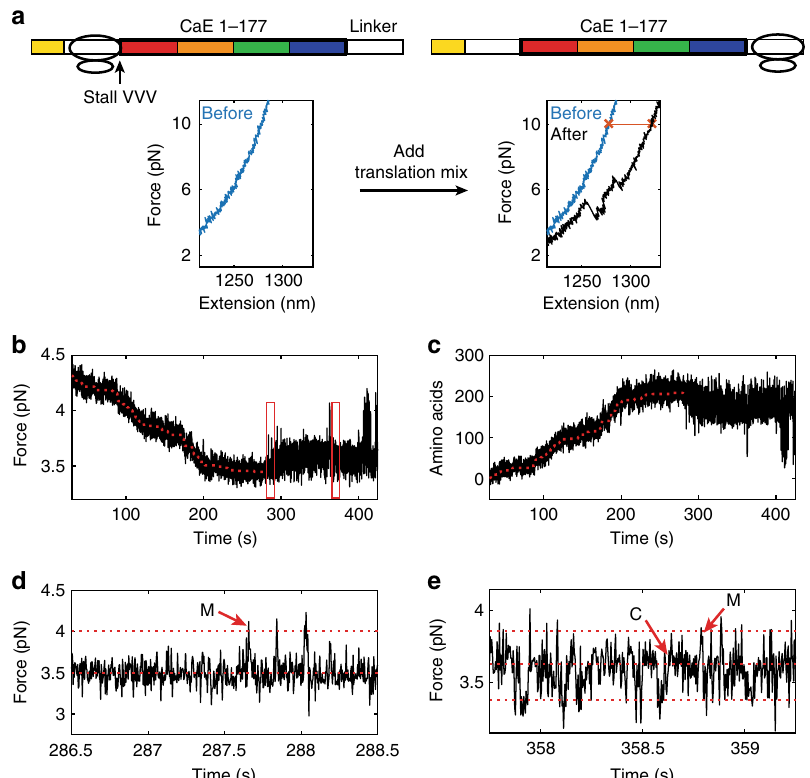
Fig. 4 Set-up for real-time elongation OT experiments. a The sequence for stalling and restart. RNCs were stalled at a three-valine repeat (see Supplementary Fig. 5) and restarted with the addition of translation mix in the OT (Supplementary Table 3). The force – extension curves show the lengthening of the tether after translating (red line denotes difference between blue and black force – extension curves) as well as folding of the full-length protein, which con fi rms the ribosome reached the end of the mRNA. b An example of ribosome translating. As each amino acid is added, the force decreases as the tether gets longer. The fi t is shown as a red dotted line. c The trajectory is converted to amino acids using a worm-like-chain model. d A zoom of the panel in b that shows the folding region. The red arrows show the misfolded state and the dotted line the expected size for state M. e A zoom of the panel in b that shows the folding region later in time. At this point, both C and M are accessible (dotted lines show expected sizes, arrows mark some the transitions). Representative molecule from n = 12. Source data are provided as a Source Data fi